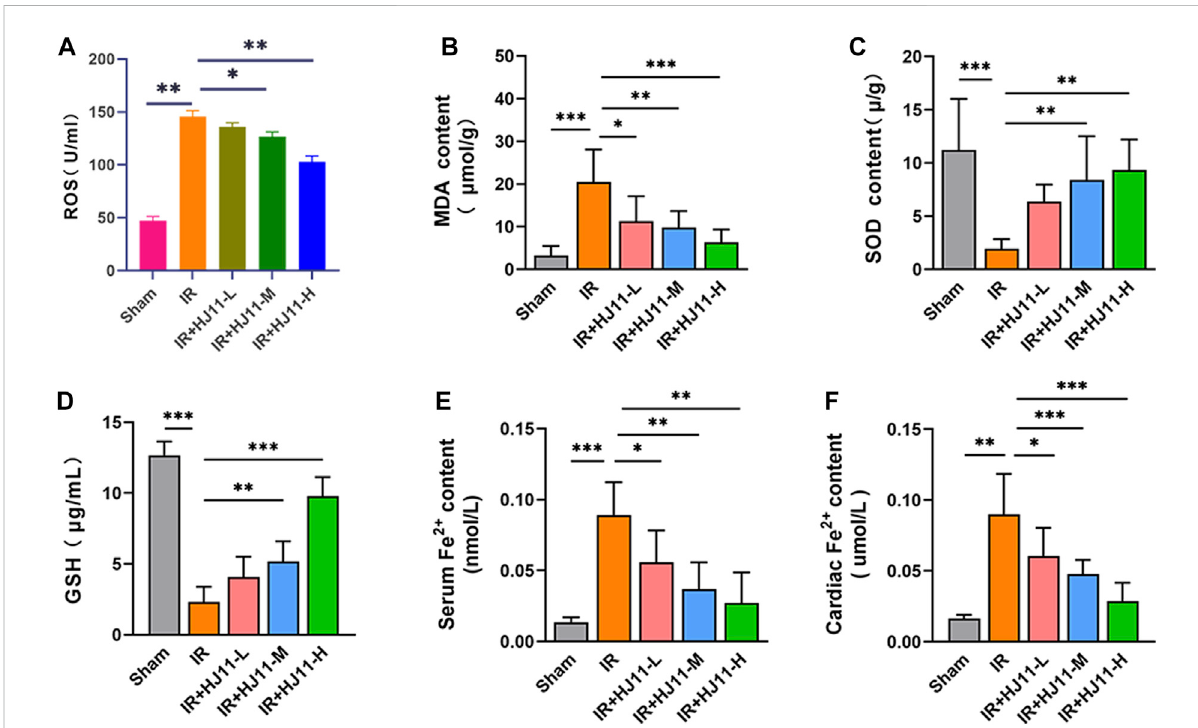
Effect of HJ11 decoction on oxidative stress and iron ion levels in rats with myocardial I/R injury. (A – D) HJ11 decoction decreased the levels of reactiveoxygenspeciesandmalondialdehydebutincreasedthelevelsofsuperoxidedismutaseandglutathioneinthemyocardialtissuesofratswith myocardial ischemia-reperfusion (I/R) injury. (E,F) HJ11 decoction reduced the level of iron ion accumulation in theserum and myocardial tissues of ratswithmyocardialI/Rinjury.* p < 0.05.** p < 0.01.*** p < 0.001.Dataareshownasmean±standarddeviation.N=3 –